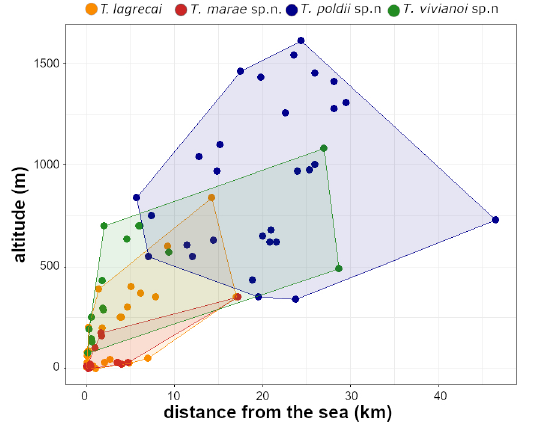
Fig. 82. Spatial characterization of the sites where the four species treated in this study were